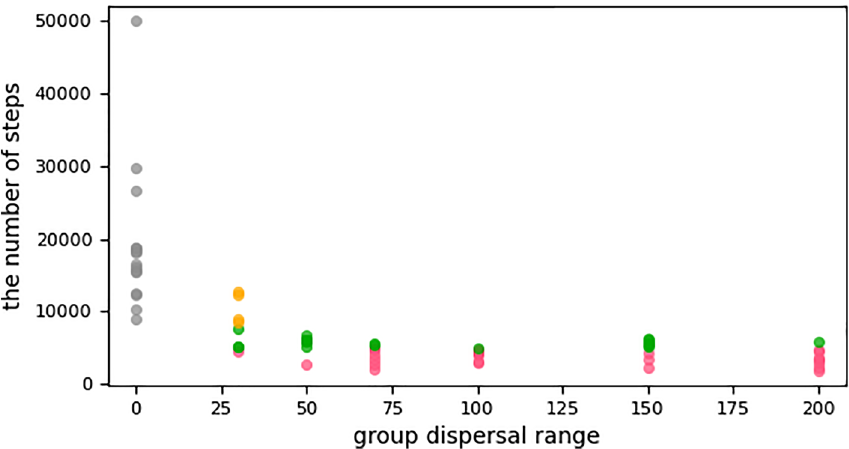
Figure 2. The runs that finished in favor of cooperators: (gray dots) most of these runs finished from 9000 to 30,000 steps by the complete extinction of cheaters, except one run reached the stop limit of our experiments at 50,000 steps, as three cheater agents succeeded to persist. The group dispersal range was 0 in all these runs. Therefore, cheaters cannot violate the spatial structure mechanism. The runs that finished in favor of cheaters by the complete extinction of cooperators: (1) (orange dots), runs finished after 8220 steps. (2) (green dots), finished from 5000 to 8220 steps. (3) (pink dots), finished before 5000 steps.